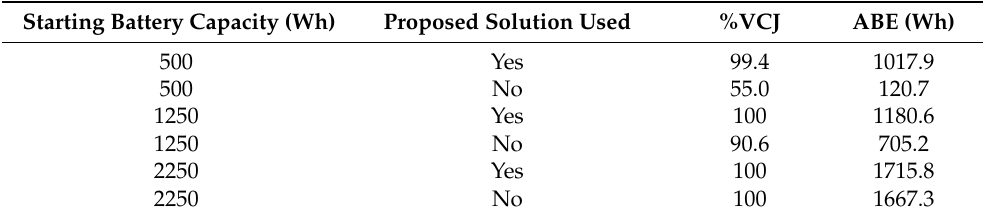
Table 5. Our detour computation scheme vs. the SUMO baseline routing algorithm: the case of the Manchester road